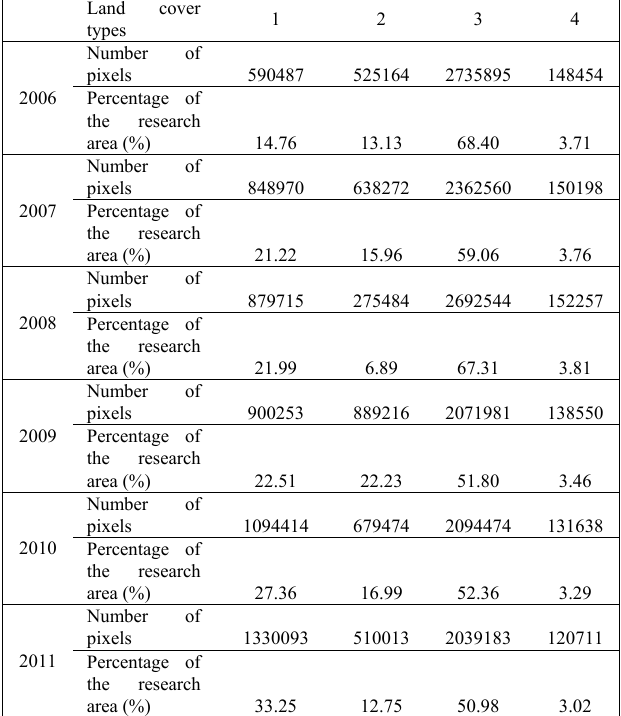
Table 3. Statistical results for the classification of the six